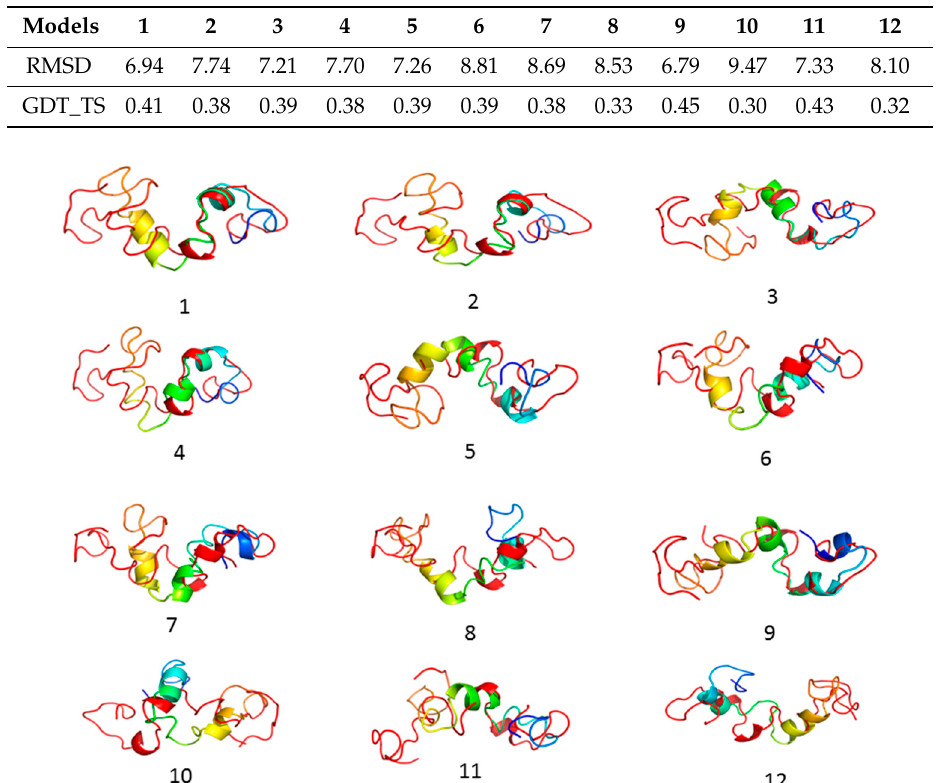
Figure 3. Tau protein 3D simulated structures results displaying the 12 models that employed restrained backbone flexibility during energy minimization. Such an iterative scheme is effective in escaping any local minima and moving closer to the native structure. All 12 simulated protein models and fluctuated residue profile plots are displayed in Figure 4a. The final 3D simulated structures were superimposed models, and the final residue fluctuated plot is displayed in (Figure